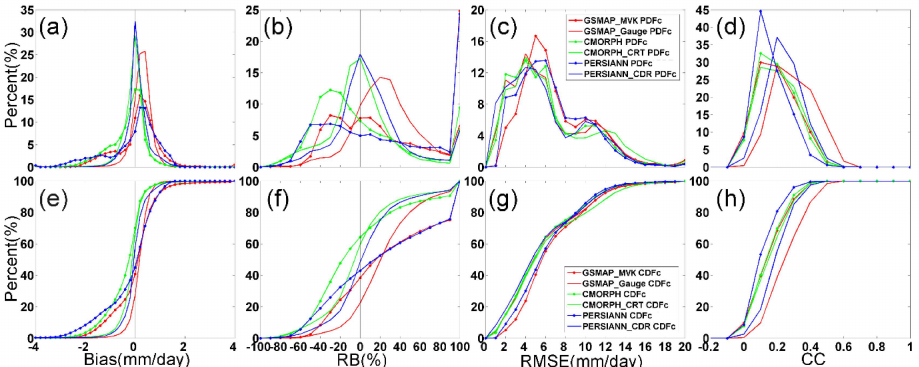
Figure 11. Probability (Cumulative) Distribution Functions PDFc (CDFc) for spatial ( a , e ) Bias; ( b , f ) RB; ( c , g ) RMSE; and ( d , h ) CC values shown in Figure